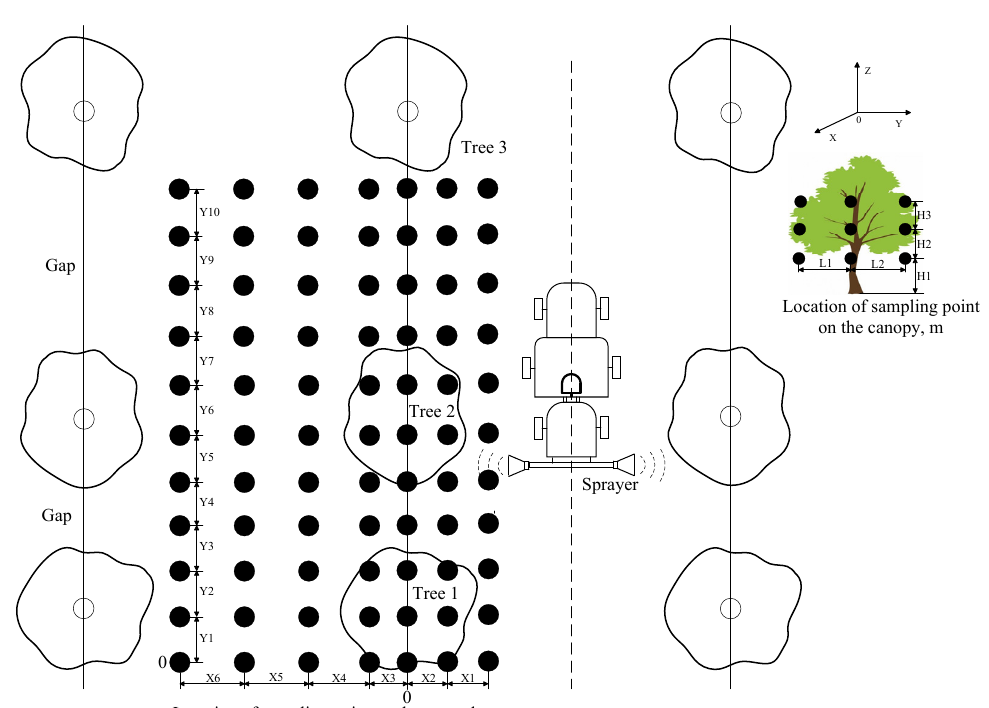
Figure 6. Sampling point layout: X : spraying direction, Y : running direction of sprayer, Z: canopy height direction.